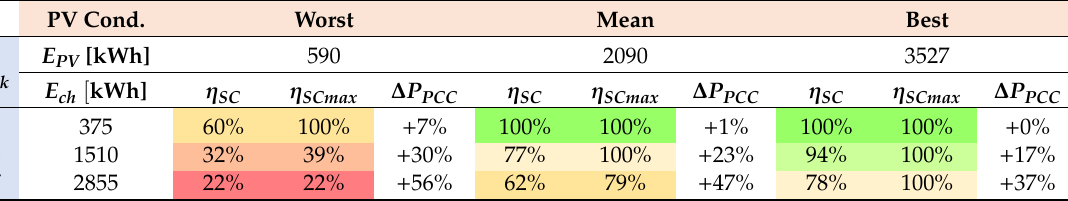
Figure 11. The PCC power profiles calculated without EVs ( red ) and with EVs charging ( blue ) according to the different values of the initial SOC. The PV generation changes according to the worst condition ( left ), the mean condition ( center ), and the best condition ( right ), as well as the ∆ P PCC values. Table 5. Performance parameters (No